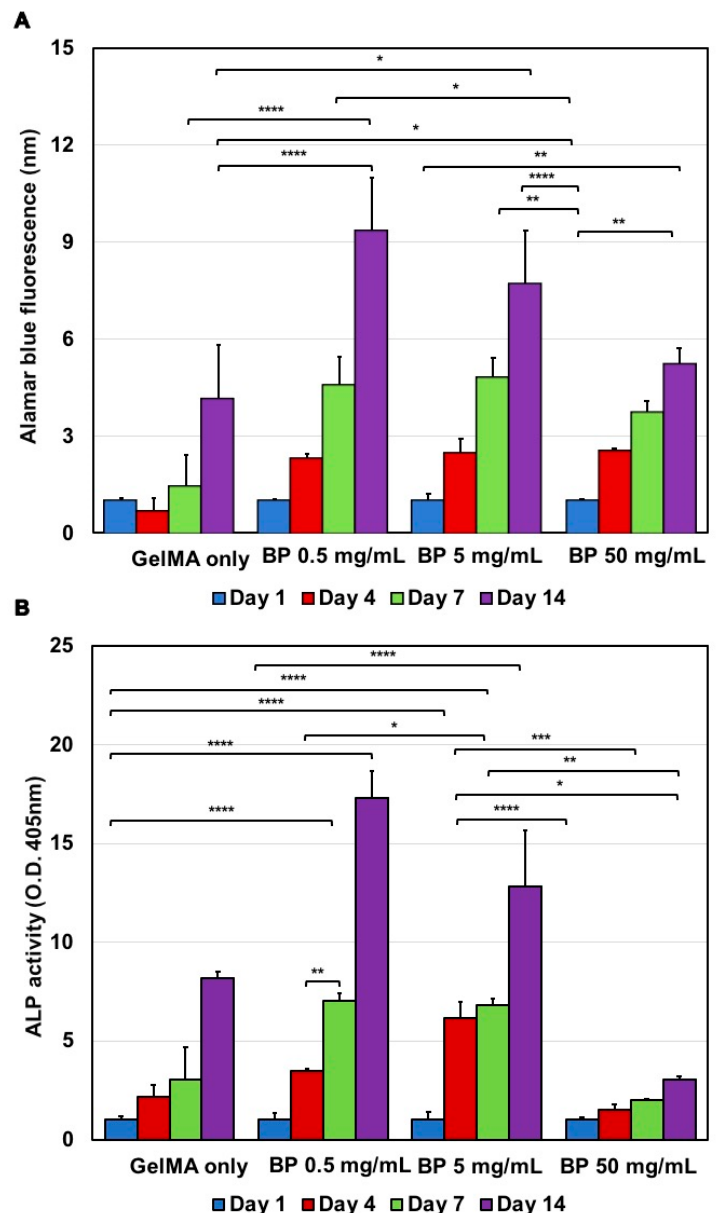
Figure 3. Cellular responses to various GelMA/BP composite hydrogels. ( A ) Metabolic activity of the 3D-encapsulated preosteoblasts from day 1 to day 14 with enhanced effects shown at high BP concentrations. Fluorescence values of alamar blue assay at 560/590 nm and normalized to day zero (Ex/Em); error bars: ± SD, * p < 0.05, ** p < 0.01 and **** p < 0.0001). ( B ) Alkaline phosphatase (ALP) activity of 3D-encapsulated preosteoblasts from day 1 to day 14 reflected behavior shown in osteogenic differentiation. ALP activity values represented as absorbance values at 450 nm and normalized to day zero values (Error bars: ± SD, * p < 0.05, ** p < 0.01, *** p < 0.001, and **** p < 0.0001).